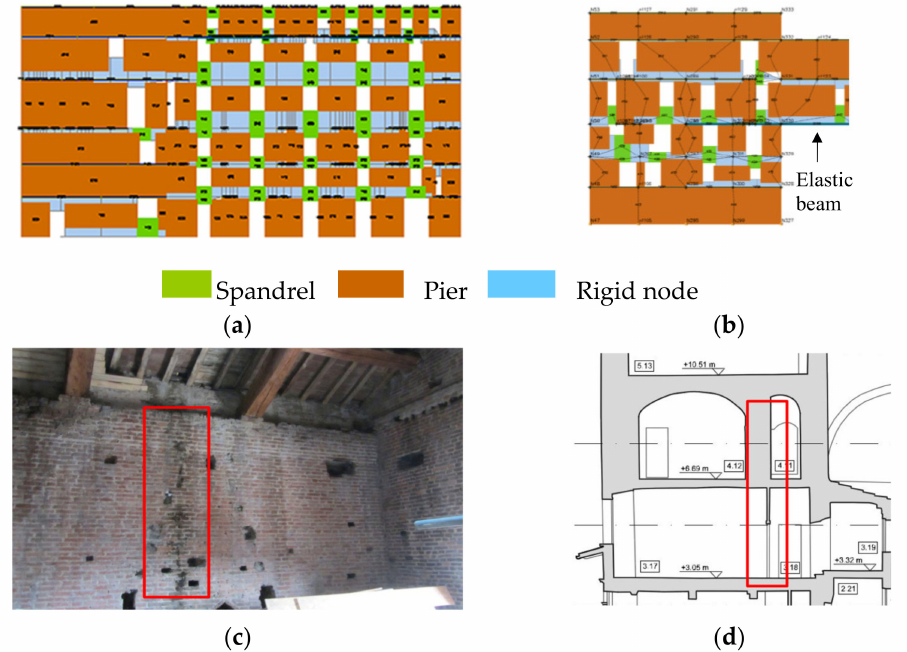
Figure 7. ( a ) Equivalent frame idealization of the façade overlooking the Broletto square; ( b ) example of modelling strategies assumed to guarantee a proper actions’ repartition to the structural elements under the non-continuous walls; ( c , d ) examples of vulnerability-driving factors: a flue and a non- continuous wall,